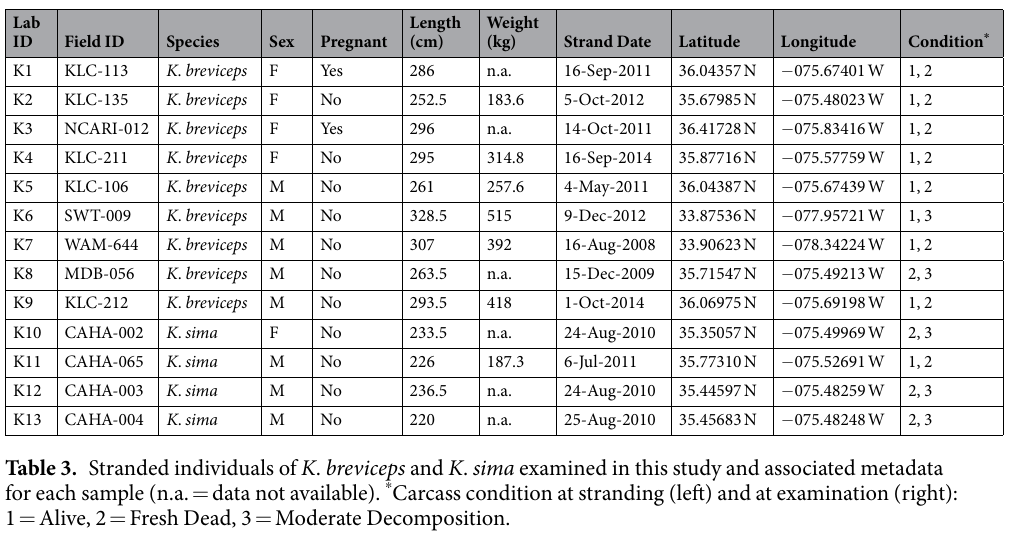
Sample Collection, DNA Extraction and Illumina Sequencing.